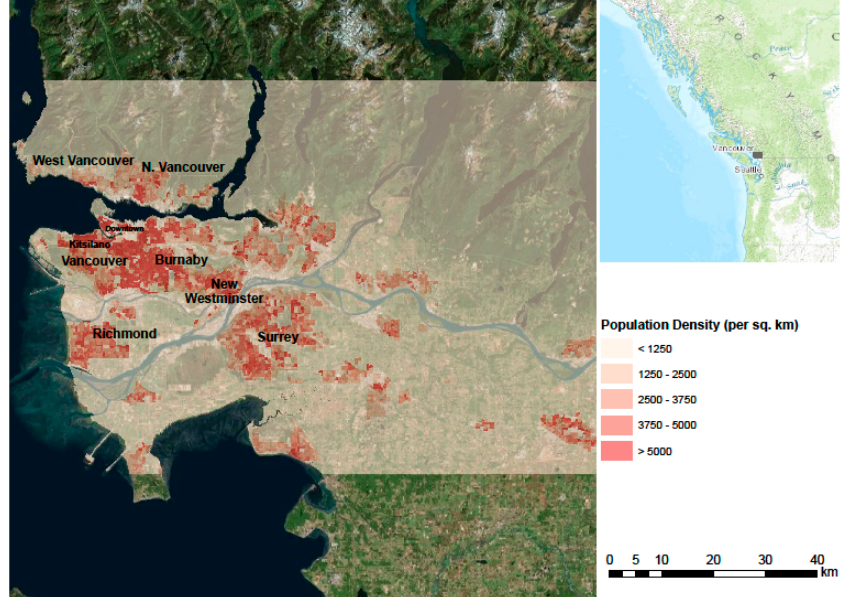
Figure 2. Study site in the greater Vancouver area. A Landsat 5 TM image forms the background, the extent of the study area is indicated in semi-transparent grey, and the population density is shown in shades of red.